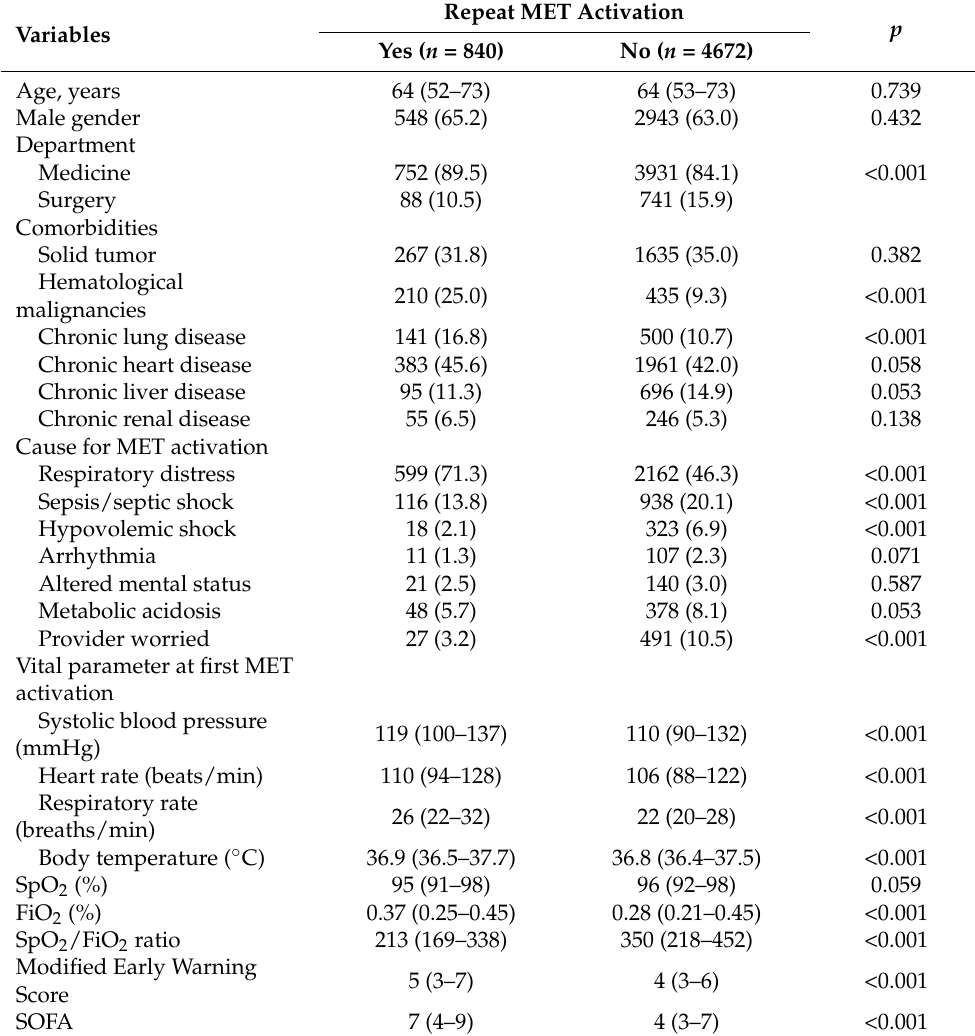
Table 1. Baseline characteristics of the patients at time of contact with medical emergency team.